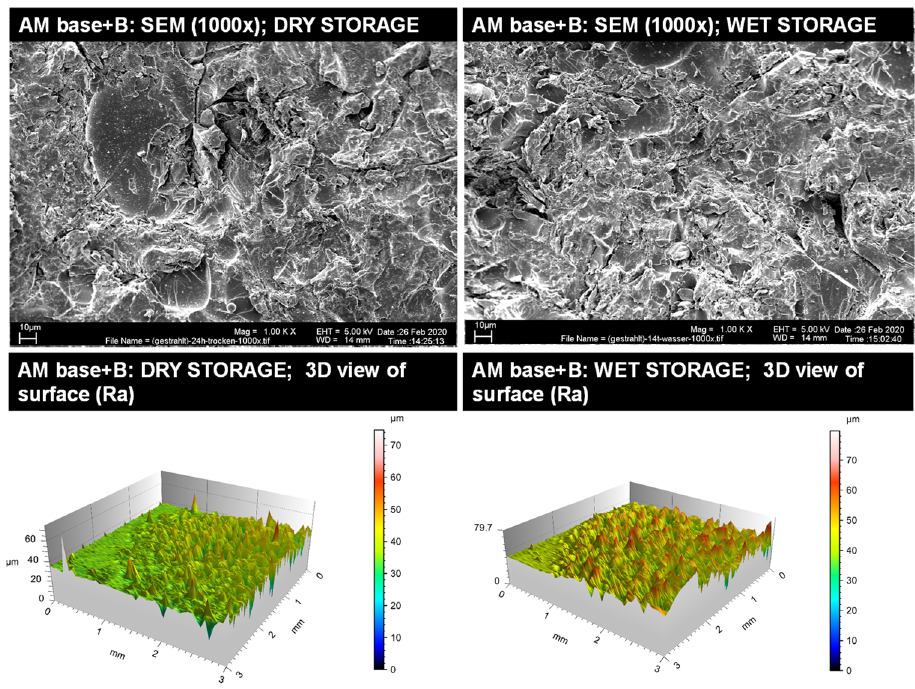
Figure 5. Qualitative insight of the AM base group blasted (B) via SEM imaging in 1000× magnification ( top ) and surface roughness profiles ( below ) for dry storage ( left ) and wet storage ( right ). Please note the differences in the scaling of the roughness profiles.